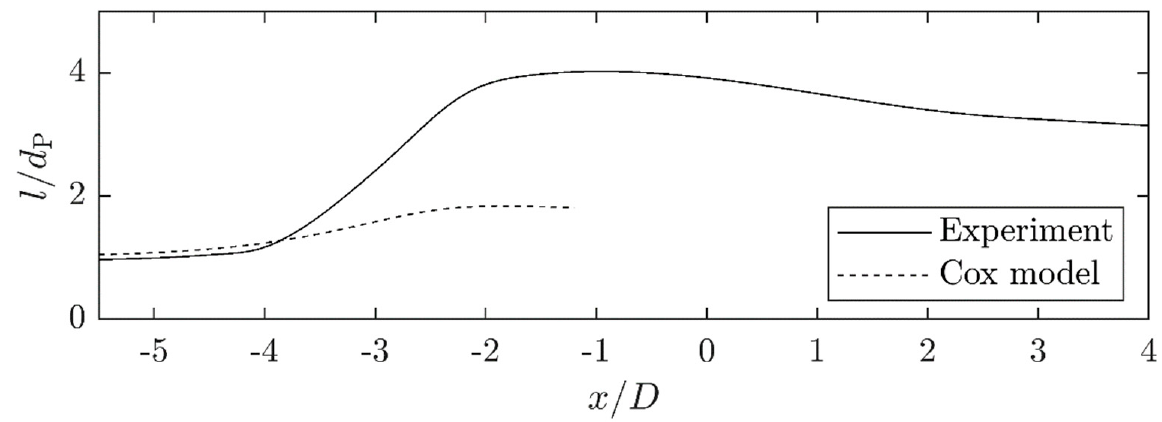
Figure 16. Comparison of the drop aspect ratio development when passing through the orifice between the experimental measurement and the numerical simulation according to the Cox for a high viscosity drop ( λ exp = 10.8/ λ num = 10.5) at a Reynolds number of Re = 2000. In the case of the two highly viscous ( λ = 10.8) drop deformation curves at Reynolds numbers of 𝑅𝑒 (cid:3404) 2000 and 𝑅𝑒 (cid:3404) 4000 , the numerical calculations deviate strongly